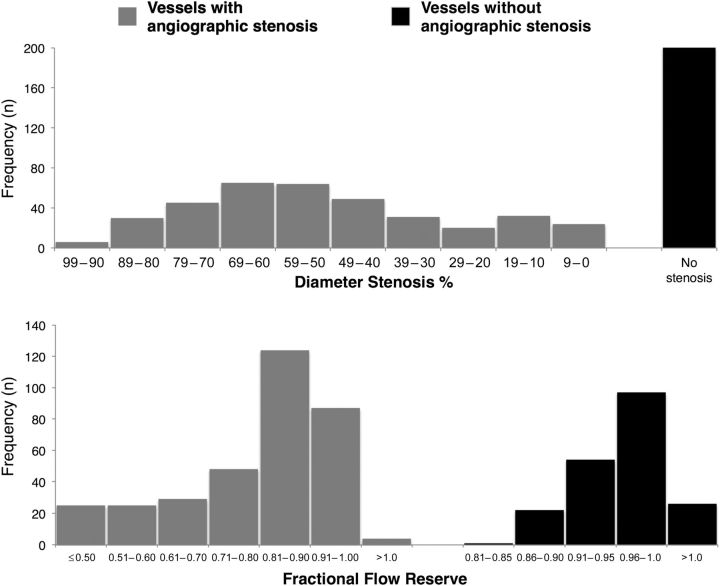
Distribution of the coronary arteries measured stratified according to percentage of diameter stenosis % (upper panel) and fractional flow reserve (lower panel).